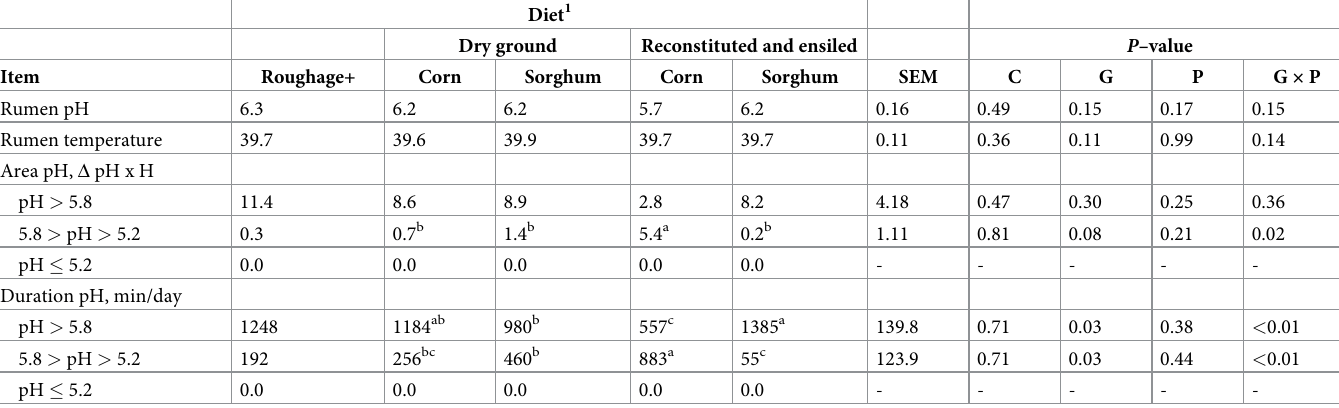
C, effect of concentrate level (Roughage+ diet versus remaining diets); G, effect of grain source; P, effect of processing method; G × P, effect of interaction between grain source and processing method. 1 Four diets were composed of approximately 28% corn silage and 72% concentrate (DM basis). An additional diet (Roughage+) was composed of 45% corn silage and 55% concentrate (DM basis). a-c Within row, means without a common superscript significantly differ ( P �